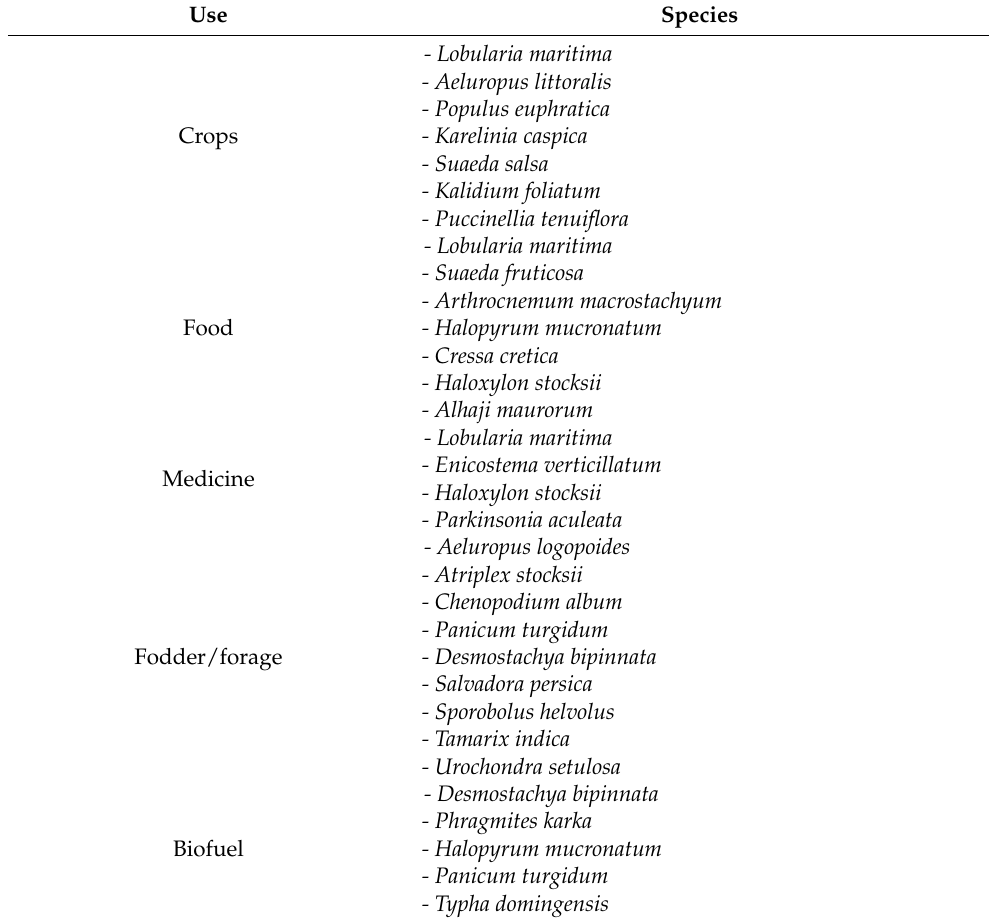
Table 1. Examples of use of selected species of halophytes